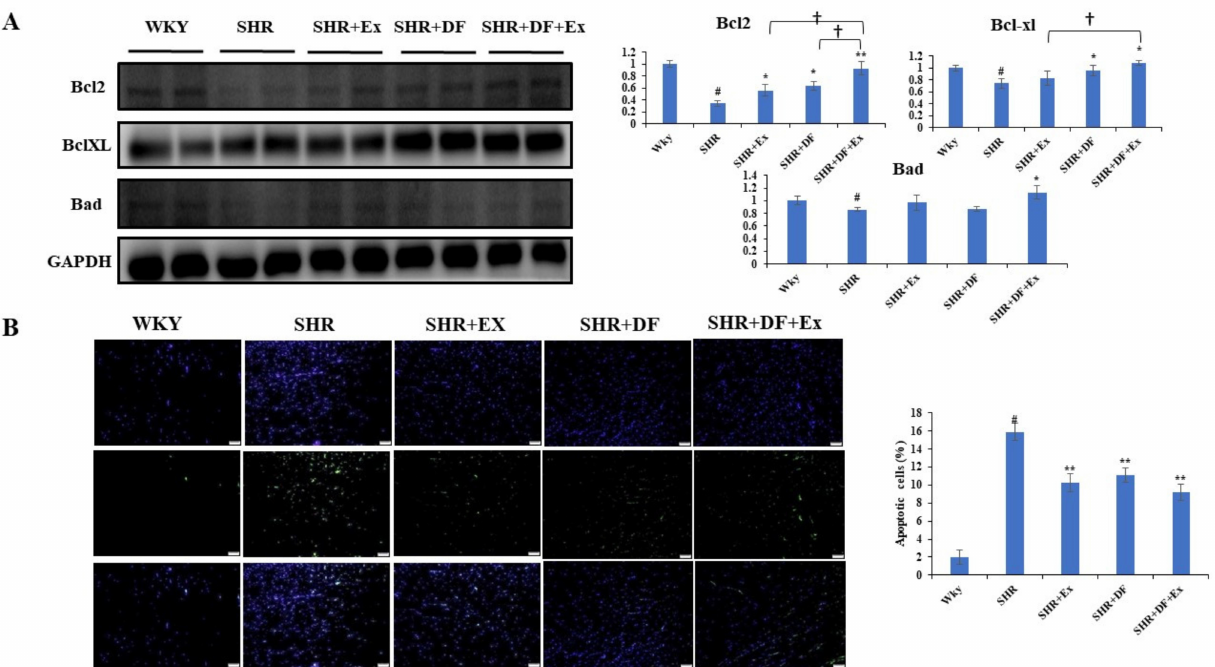
Figure 5. DF peptide administration and exercise inhibits apoptosis in SHR heart. ( A ) Western blot of apoptosis protein markers. ( B ) TUNEL assay. Each bar represents mean ± SD ( n = 8). # p < 0.01 compared to WKY, * p < 0.05 and ** p < 0.01 compared to SHR, † p < 0.05 compared to SHR + EX and/or SHR + DF.